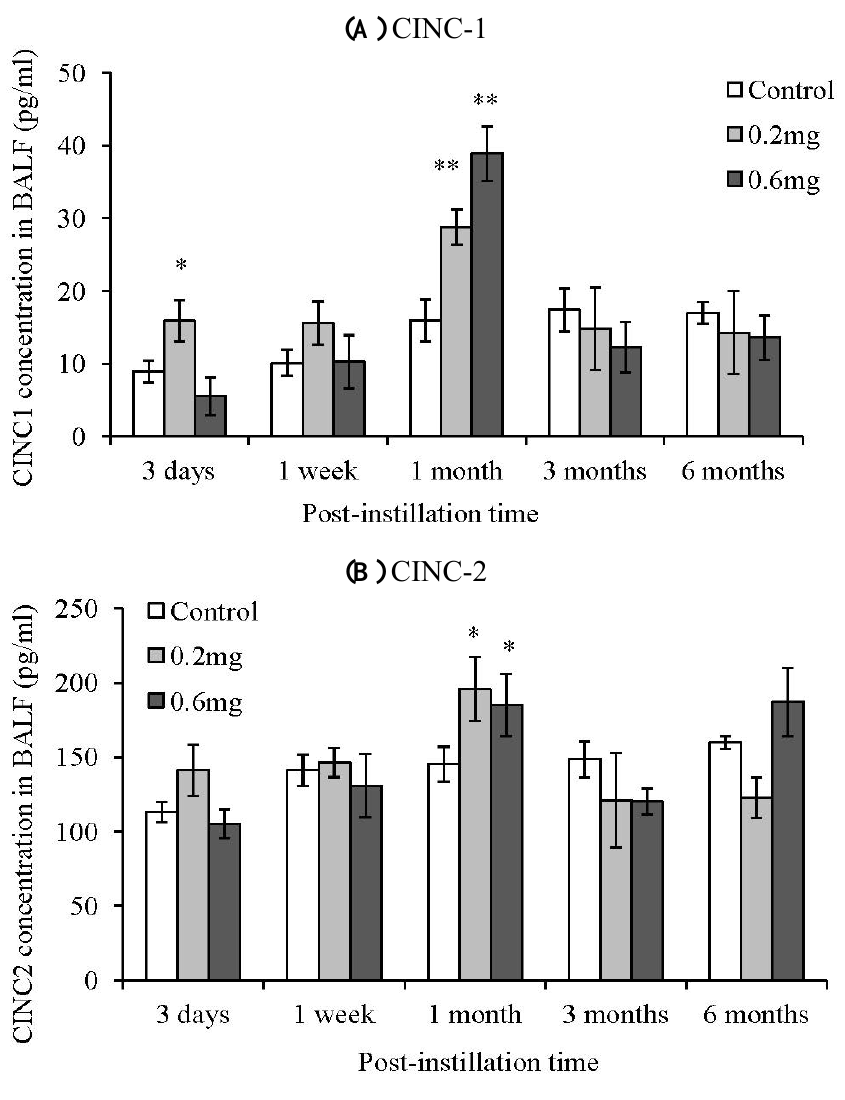
Figure 6. Concentration of CINC in BALF after intratracheal instillation of MWCNT. ( A ) CINC-1; ( B ) CINC-2. The concentrations of CINCs were measured by ELISA. Values are mean ± SE ( n = 5). * p < 0.05, ** p < 0.01 ( vs. each negative control